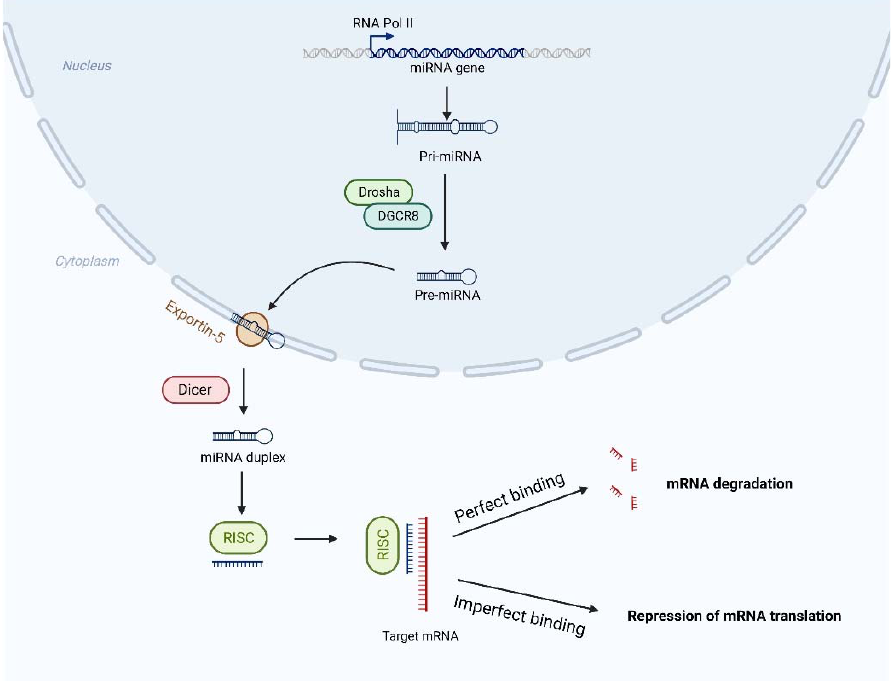
Figure 1. Schematic representation of the biosynthesis process of miRNA. Genes encoding miRNAs are transcribed to pri-miRNA, which is then converted to pre-miRNA. Pre-miRNA is transported